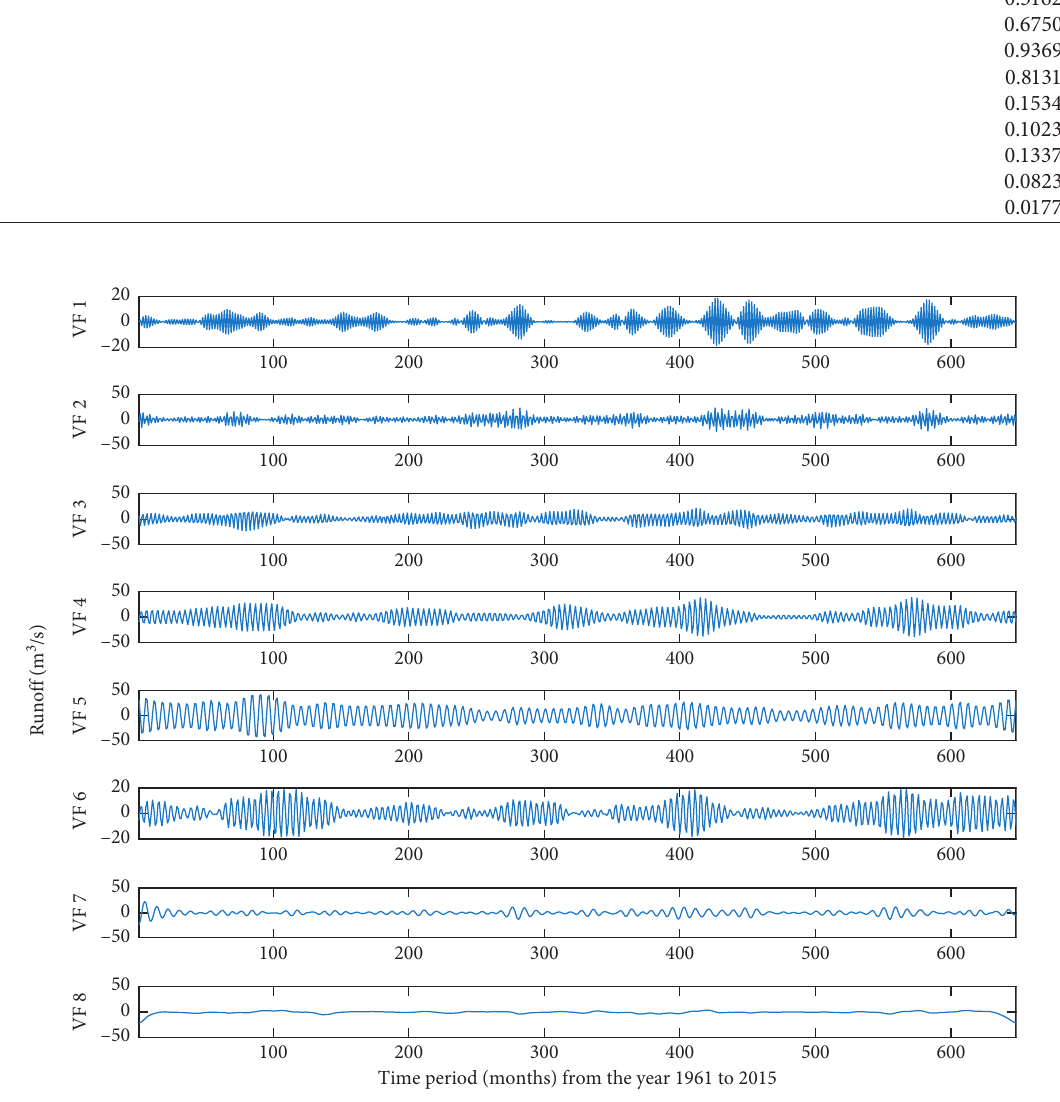
Figure 7: VMD decomposition of IMF1 (obtained after CEEMDAN decomposition).